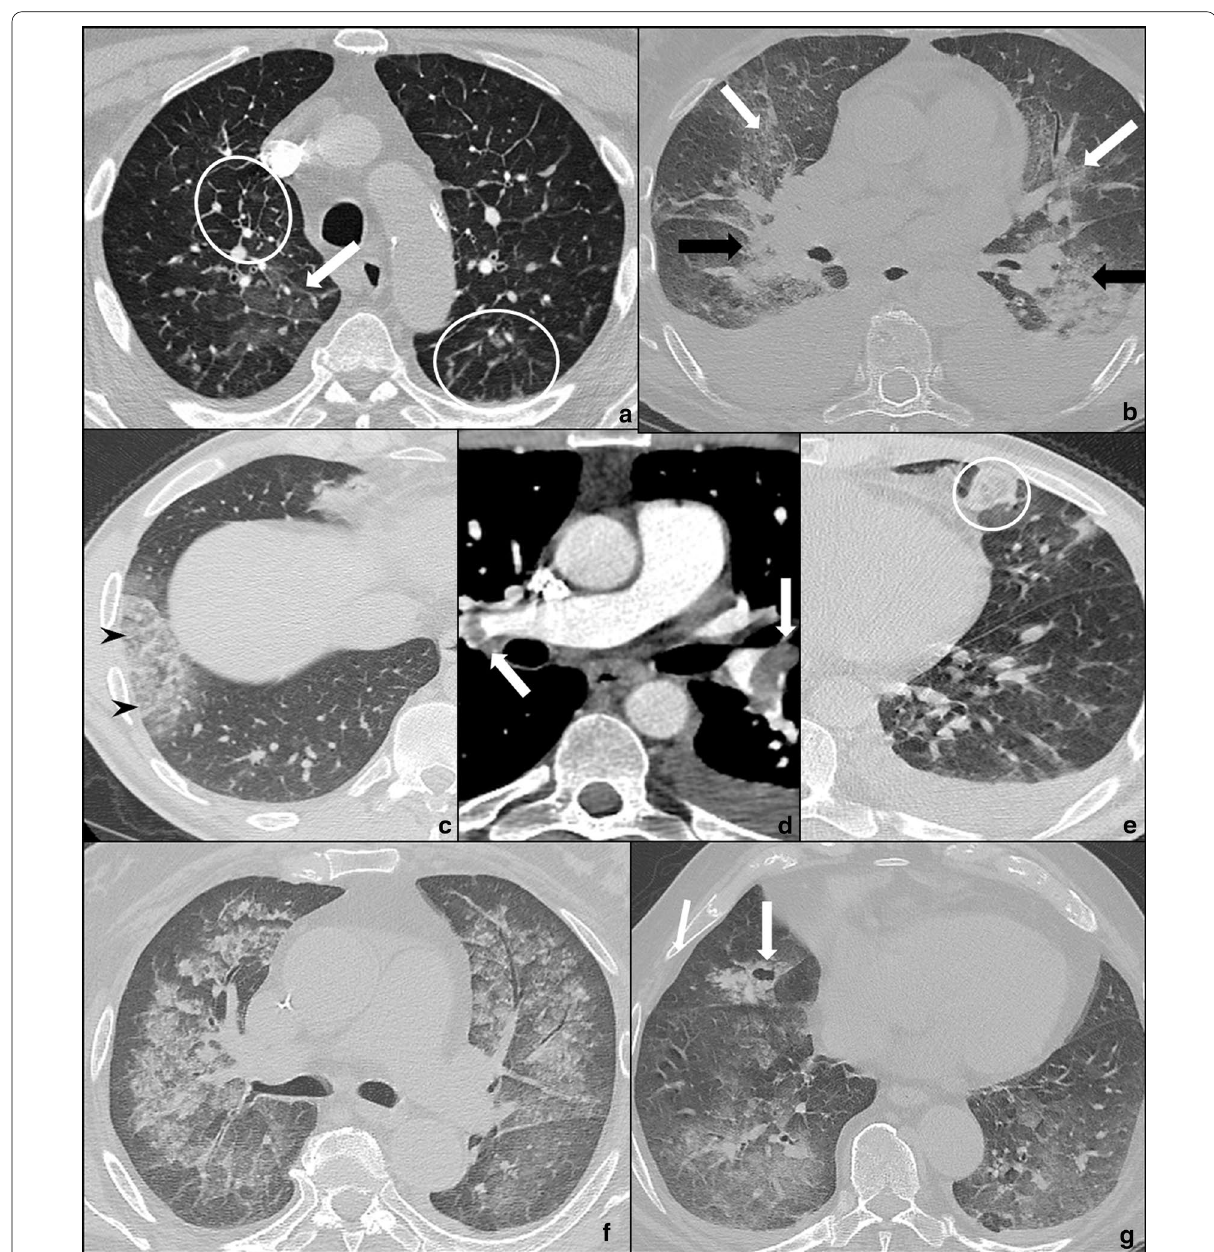
Fig. 3 a – g COVID-19 pneumonia differential diagnosis: cardiovascular pathologies. HRCTs of patients presenting with interstitial oedema ( a ) and interstitial-alveolar oedema ( b ). In a , there is extensive smooth thickening of interlobular septa (white circles in a ) coexisting with ground-glass opacities (white arrow in a ); in b , confluent perihilar consolidations (black arrows in b ) coexist with crazy paving pattern (white arrows in b ) and bilateral pleural effusions. HRTC ( c , e ) and AngioCT ( d ) in patients affected by APE: bilateral emboli (white arrows in d ) caused two pulmonary infarcts manifesting, respectively, as an area of crazy paving (black arrowheads in c ) and a consolidation with a hypodense core (“reversed halo sign”, white circle in e ). HRTC of a patient affected by Granulomatosis with polyangiitis ( f , g ) showing massive centroparenchymal DAH ( f ) and an excavated nodule (white arrow in g